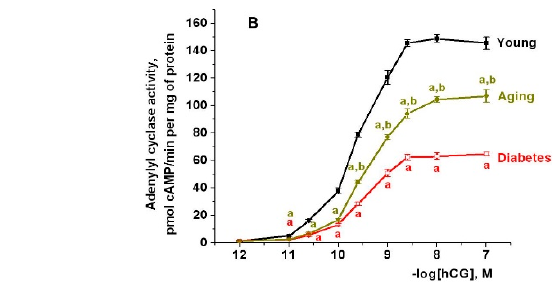
Figure 1. The concentration-dependent stimulating effects of TP4/2 ( A ) and hCG ( B ) on the basal adenylyl cyclase activity in testicular membranes isolated from the young adult, aging and diabetic rats. a —the difference between the young adult rats and the aging and diabetic rats is significant at p < 0.05; b —the difference between the aging and diabetic rats is significant at p < 0.05. The data are presented as the M ± SEM, n = 5.